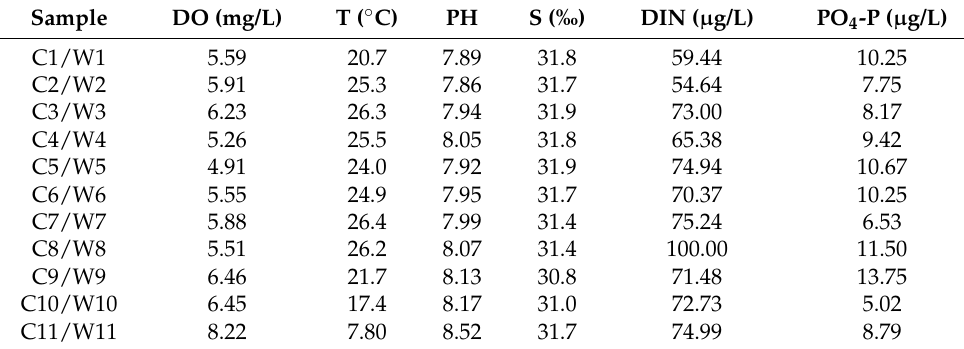
Table 2. Environmental factors near the sampling